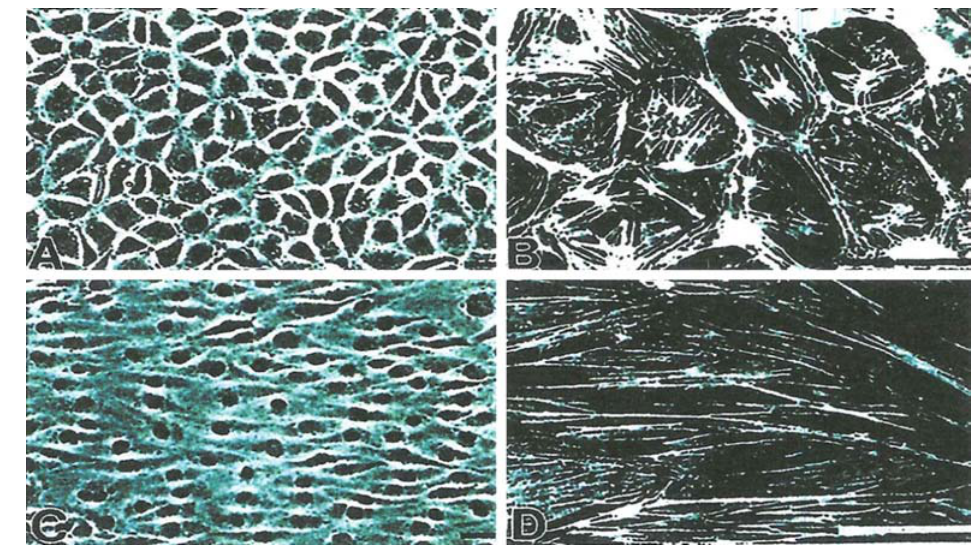
Figure 1. In vitro images of morphology and F-actin for bovine aortic endothelial cells for static conditions (A and B) and after 24 hours of laminar shear stress (C and D) with flow left to right; scale of F-actin images a factor of ten different from the morphology